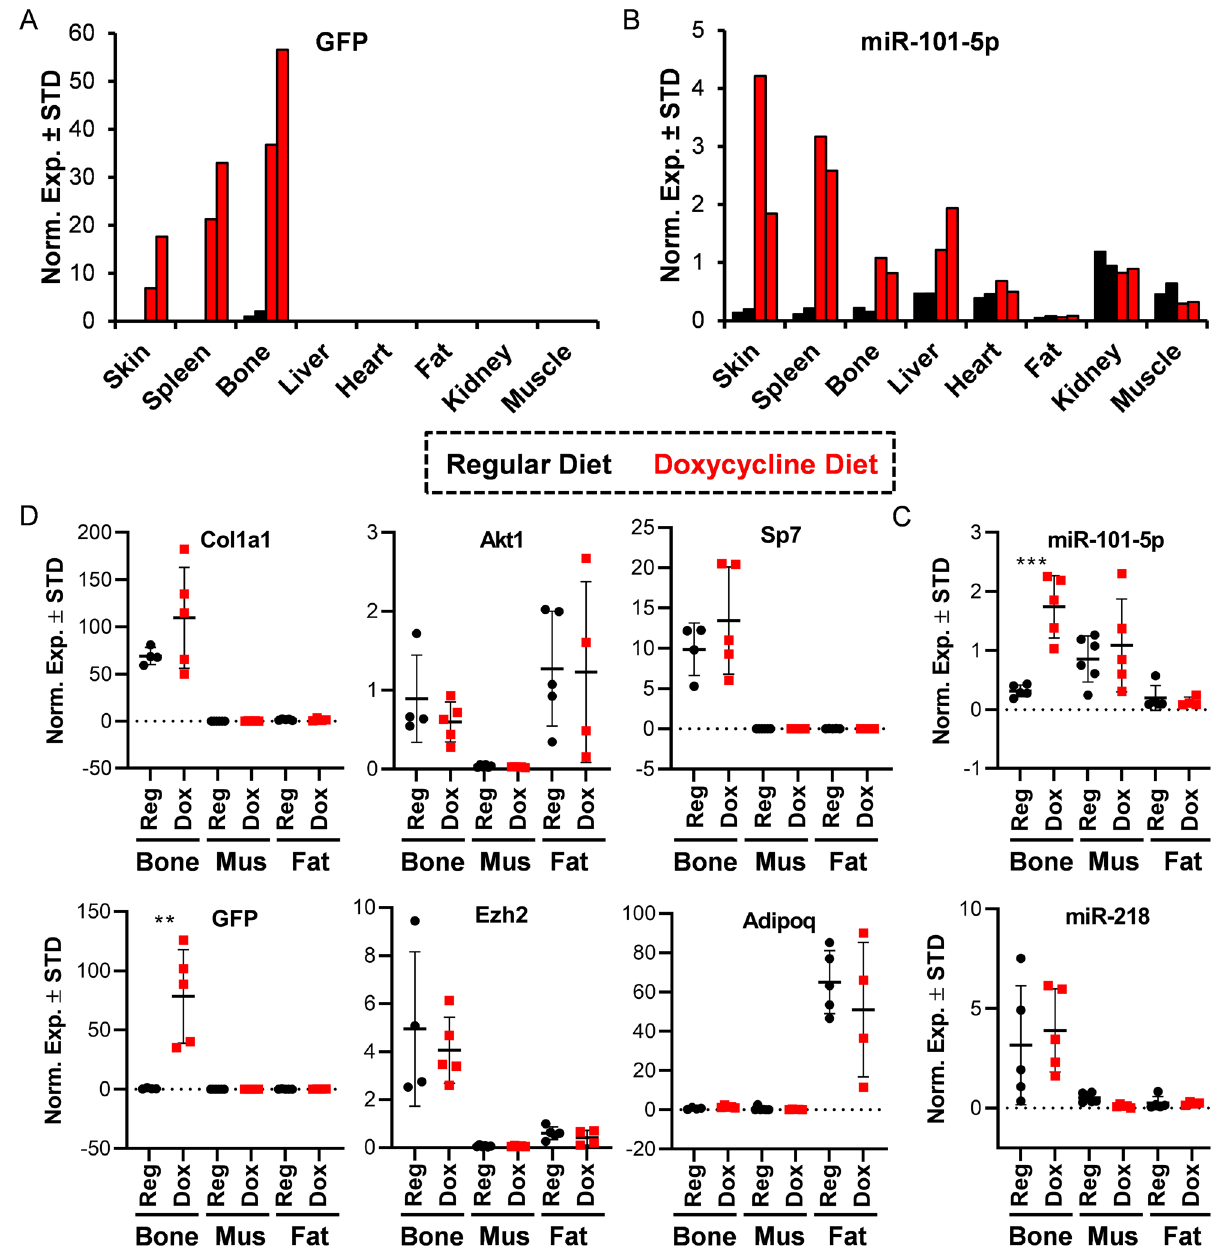
Figure 3. Establishment of miR-101a over-expressing mouse model in vivo. Three-week-old R26/101a male and female mice were maintained on regular (reg) or fed a doxycycline-supplemented (dox) diet for five weeks. Indicated tissues were assessed by RT-qPCR analysis. Administration of doxycycline is anticipated to induce miR-101a and GFP expression. An expression screen for GFP ( A ) and miR-101-5p ( B ) in eight tissues derived from eight-week-old female mice (n = 2). Quantitative expression of Col1a1, GFP, Akt1, Ezh2, Sp7/Osx, and Adipoq ( C ) and miR-101-5p and miR-218 ( D ) in bone (femora), skeletal muscle (thigh area), and fat (visceral) of eight-week-old male mice (n = 4 to 5, mean ± STD). **p < 0.01 and ***p < 0.001. We note that miR-218 was arbitrarily included as a representative miRNA to indicate selectivity in the differences in expression